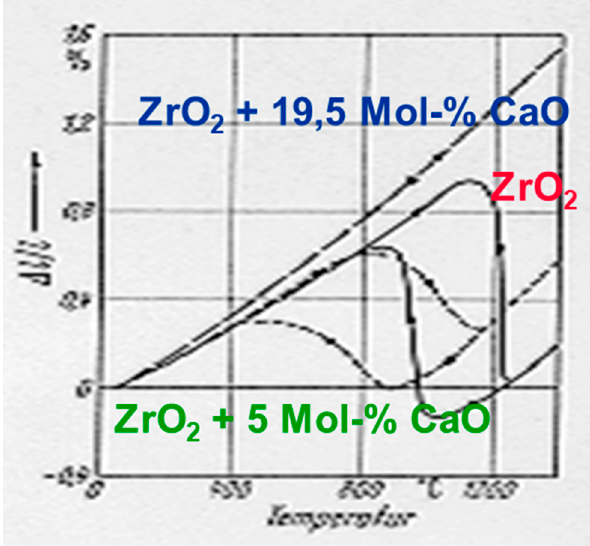
J. Compos. Sci. 2021 , 5 , x FOR PEER REVIEW Figure 4. Hysteresis curve of the reversible phase transformation in zirconia. Figure 4. Hysteresis curve of the reversible phase transformation in zirconia.